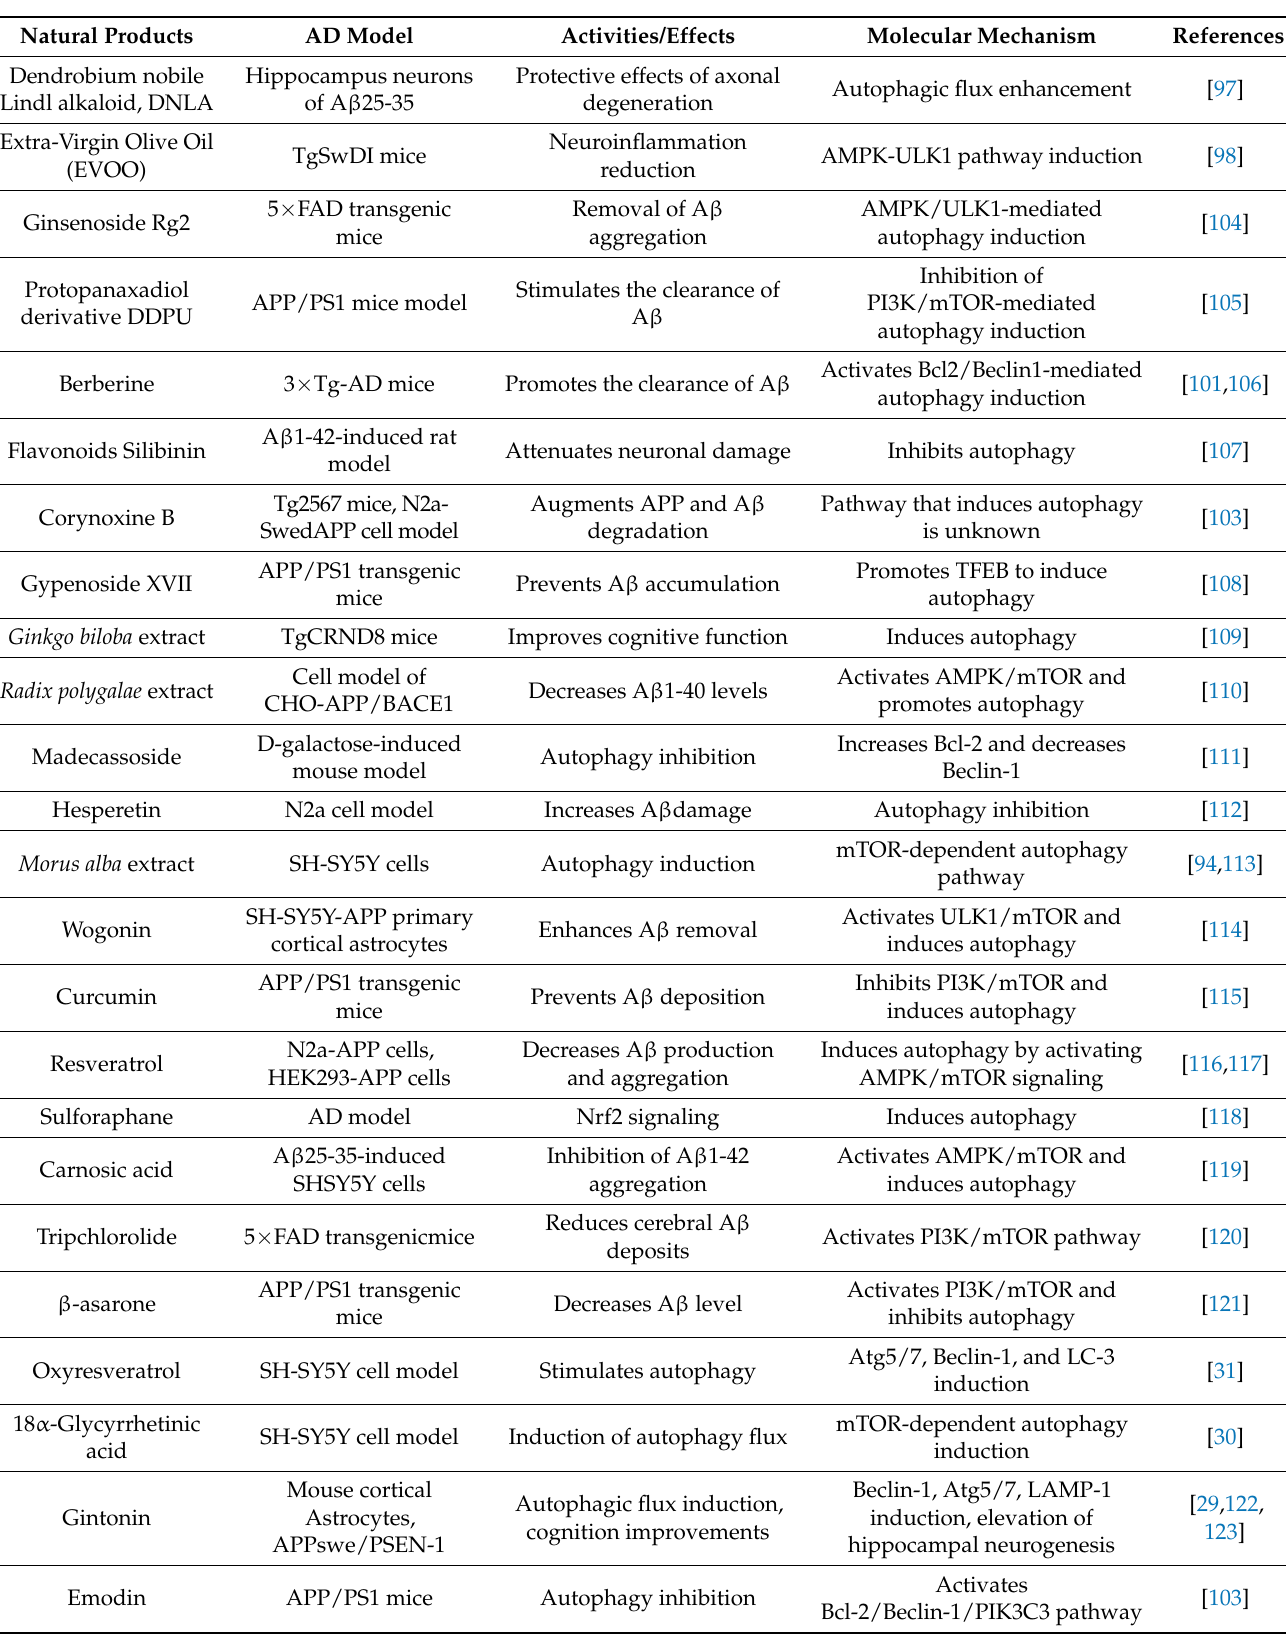
Table 1. Modulation of autophagy by natural products and their therapeutic implication in Alzheimer’s disease. Natural